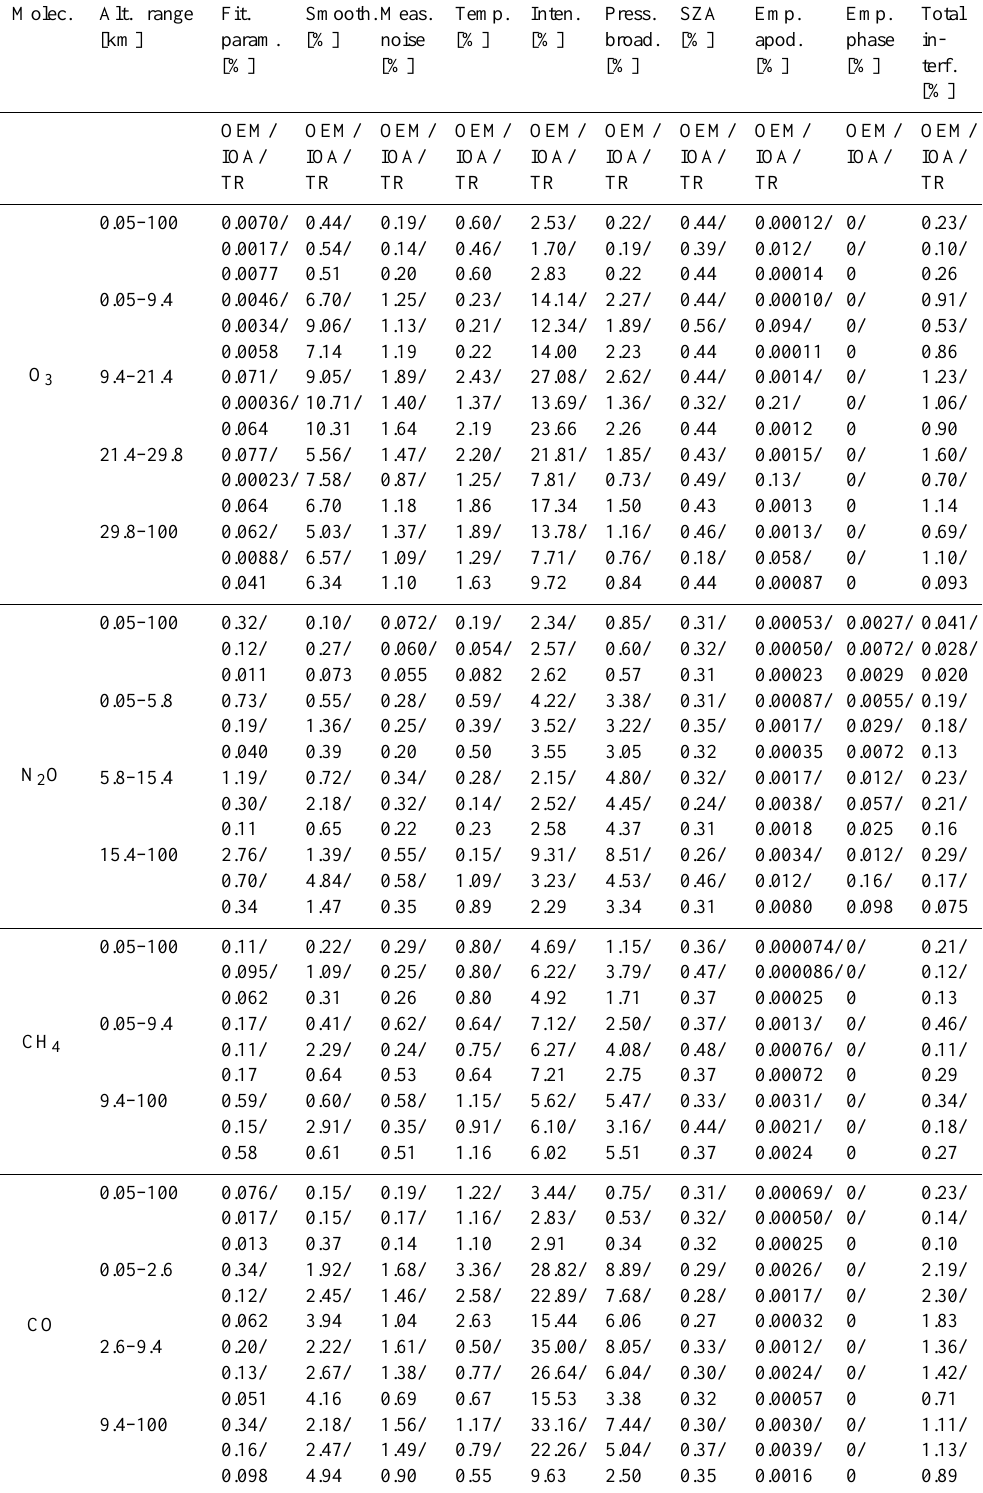
Table A1. Summary of all individual error contributions (i.e. fit parameters, smoothing, measurement noise, temperature, intensity, pressure broadening, SZA, empirical apodization, empirical phase, and interfering species error) for each target species retrieved with the OEM, IOA and